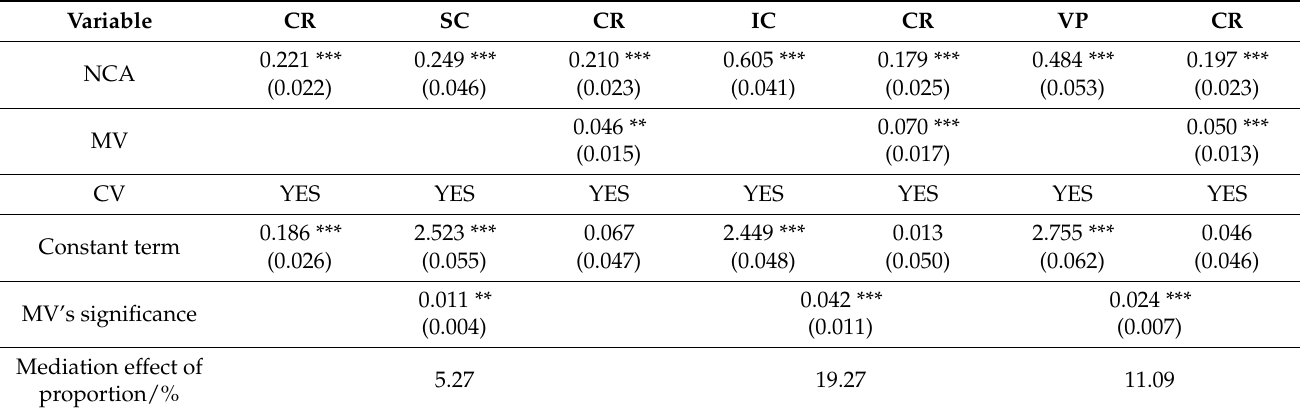
Table 3. Influence mechanism test of NCA on CR.